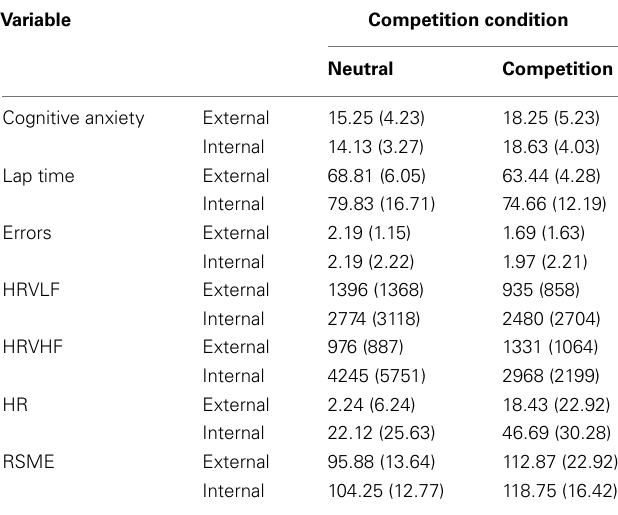
Table 3 | Mean ( ± SD) values for all variables for the competition